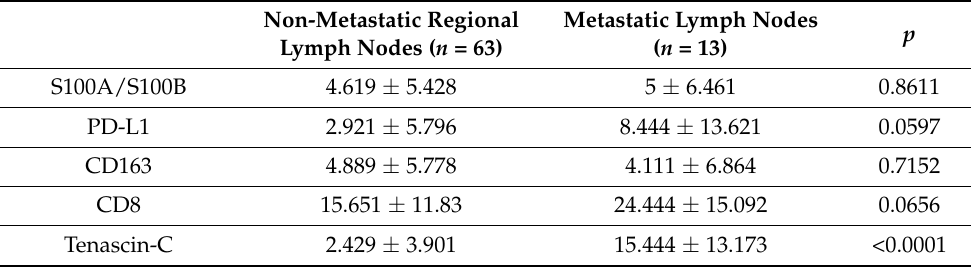
Table 4. Comparison between regional cancer-draining lymph nodes and metastatic lymph nodes.